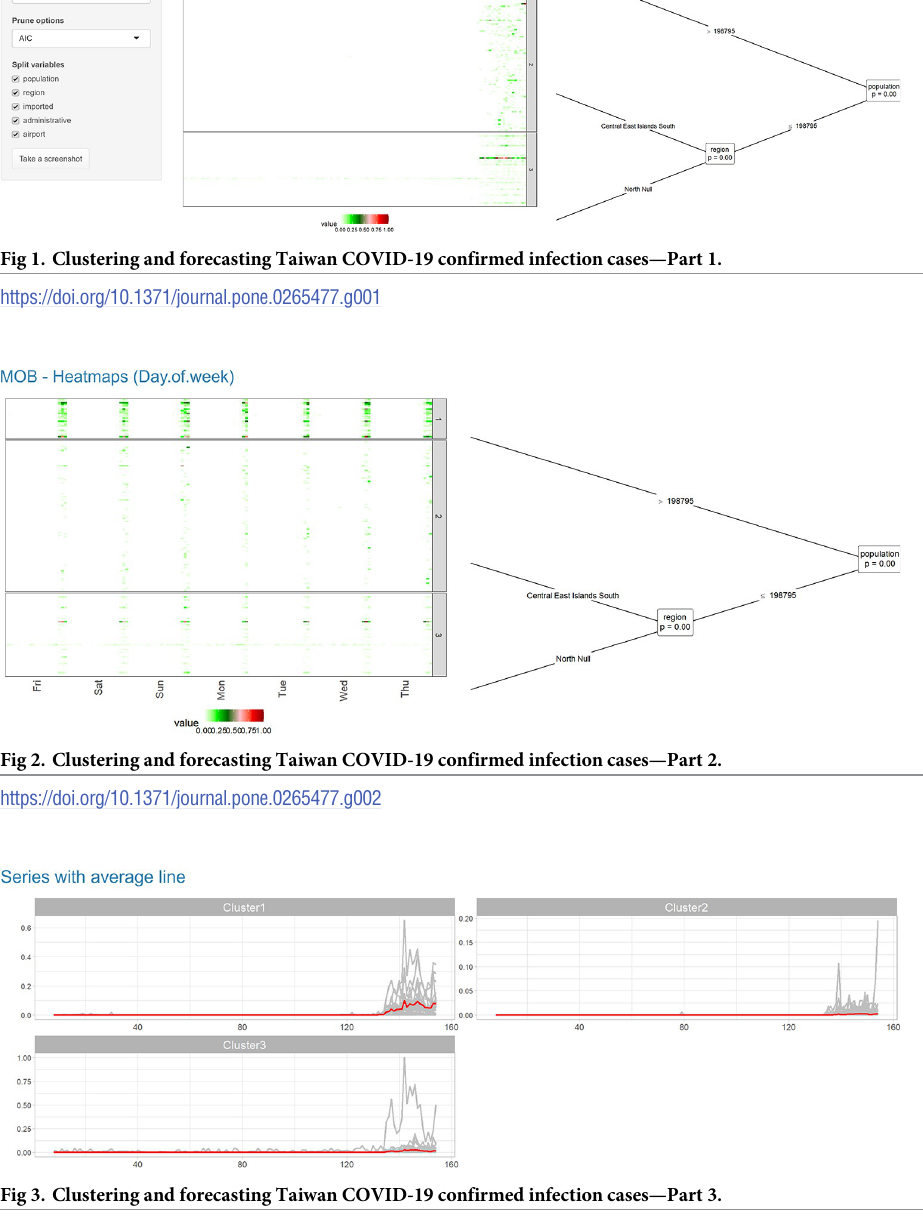
The following plot shows the time series line chart in gray and the average line in red (Fig 3). The coefficient plot displays OLS coefficients for predictors in all clusters (Fig 4). In other words, each line represents one model connecting the coefficients for each predictor. This plot is useful for users to choose the number of clusters. Also, by clicking on the coefficient points, its value will appear in the box below. The final plots, the forecast error box, and density plots, display forecast errors for the OLS and ETS methods on a one-week test set (Fig 5). In the